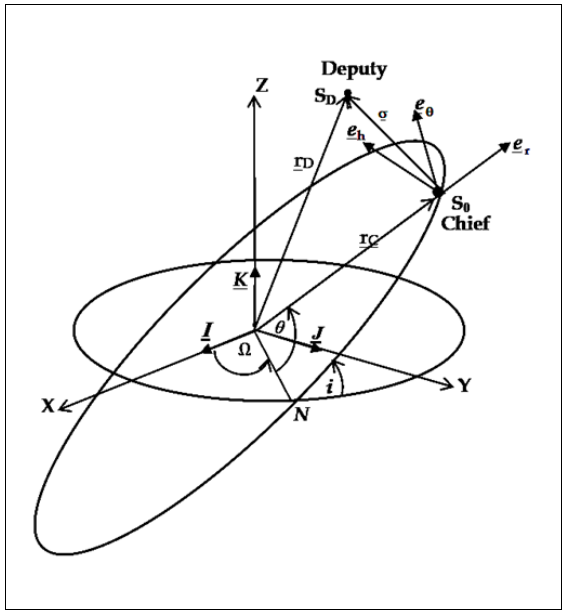
Fig. 1 ECI and LVLH